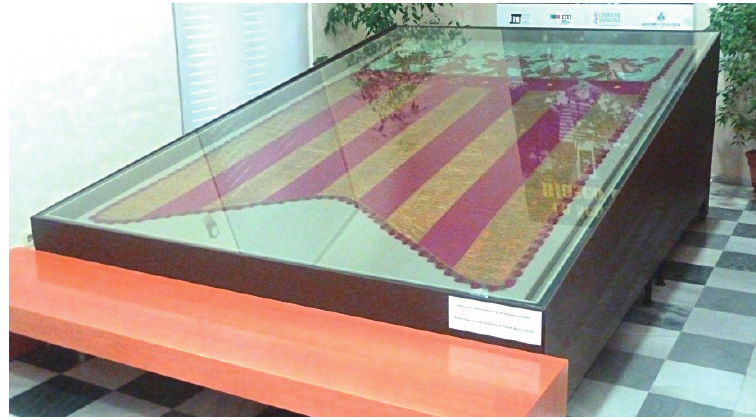
Figure 1. Restored flag in the display cabinet, Blasco Ibáñez Museum-House